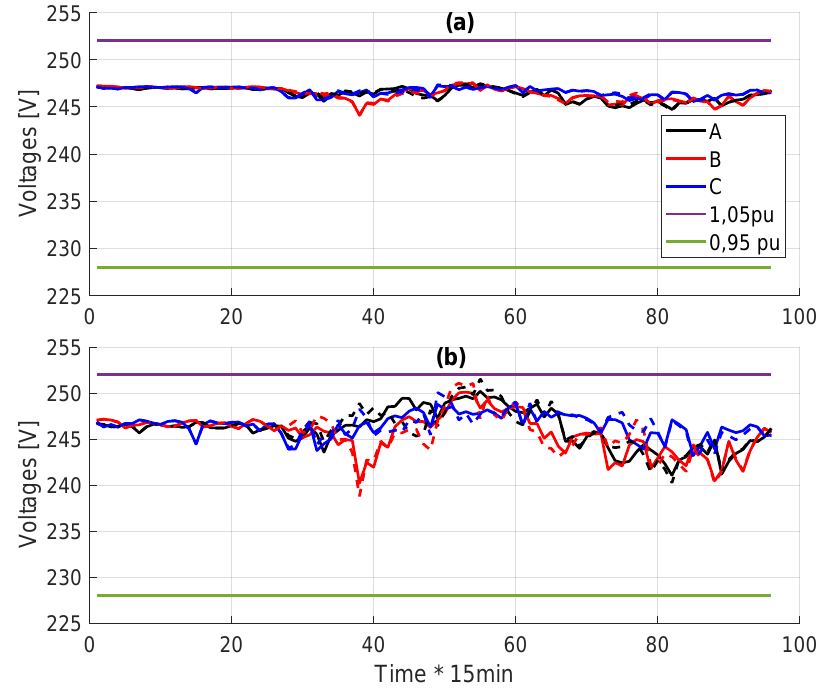
Figure 10. Voltage profile on ( a ) Transformer LV Side and ( b ) furthest node from the transformer (full—net-metering; dashed—market). Values are depicted in time in 15-min